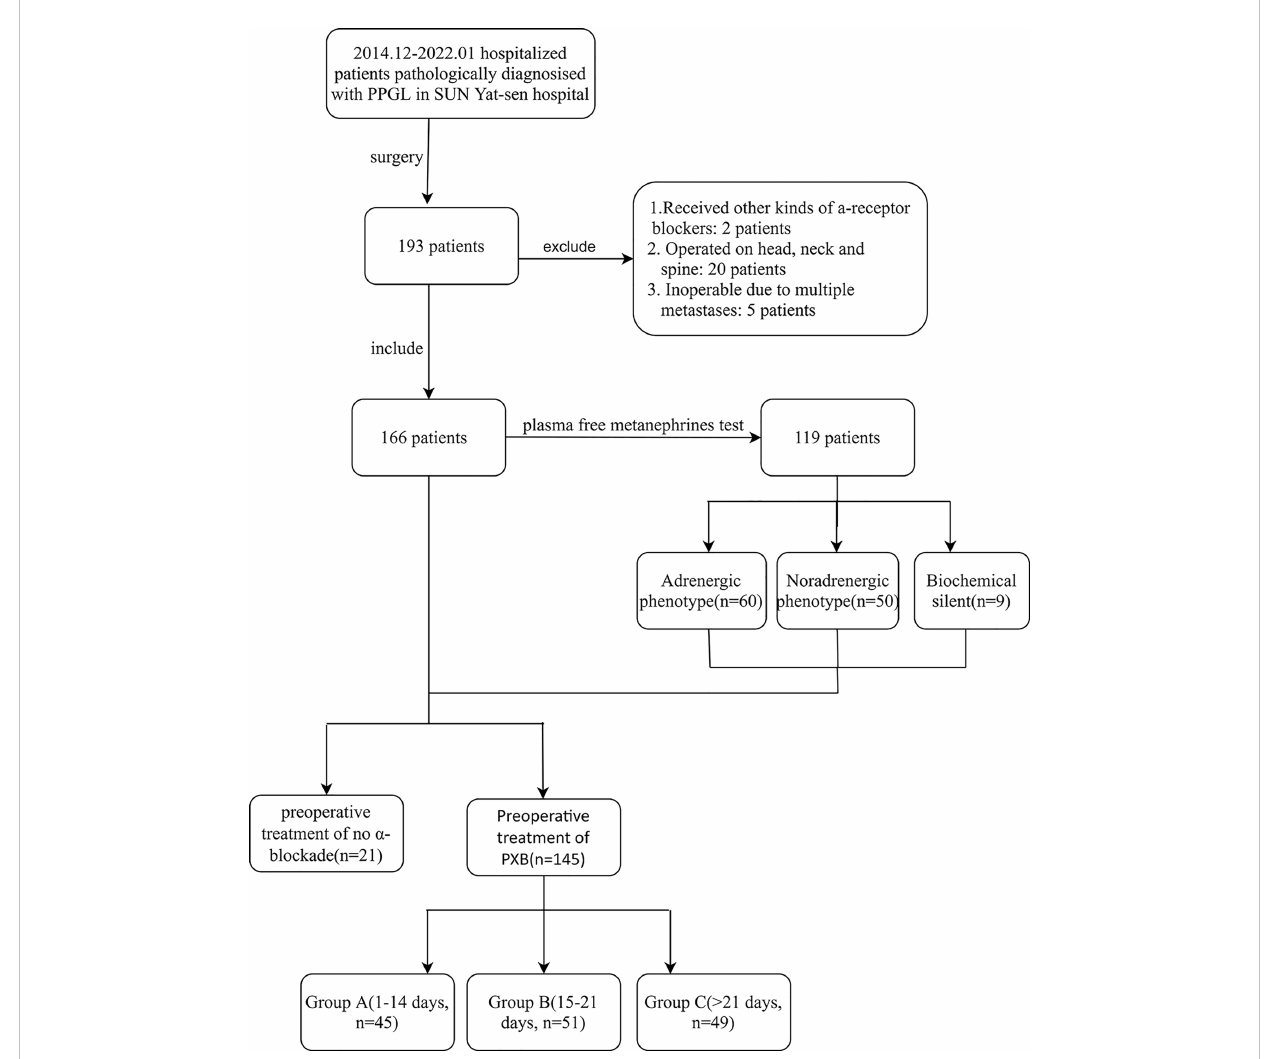
FIGURE 1 Inclusion and exclusion of subjects. PPGL, pheochromocytoma and paraganglioma; PXB, phenoxybenzamine; metanephrines, metanephrine and normetanephrine; Group A, B and C are divided according to the duration of preoperative management of